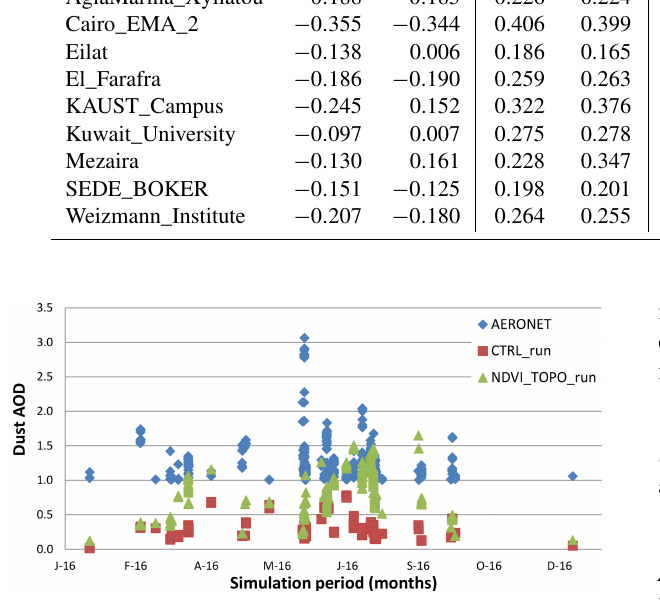
Figure 6. Time series of measured and modeled dust AOD for the cases of AERONET AOD >